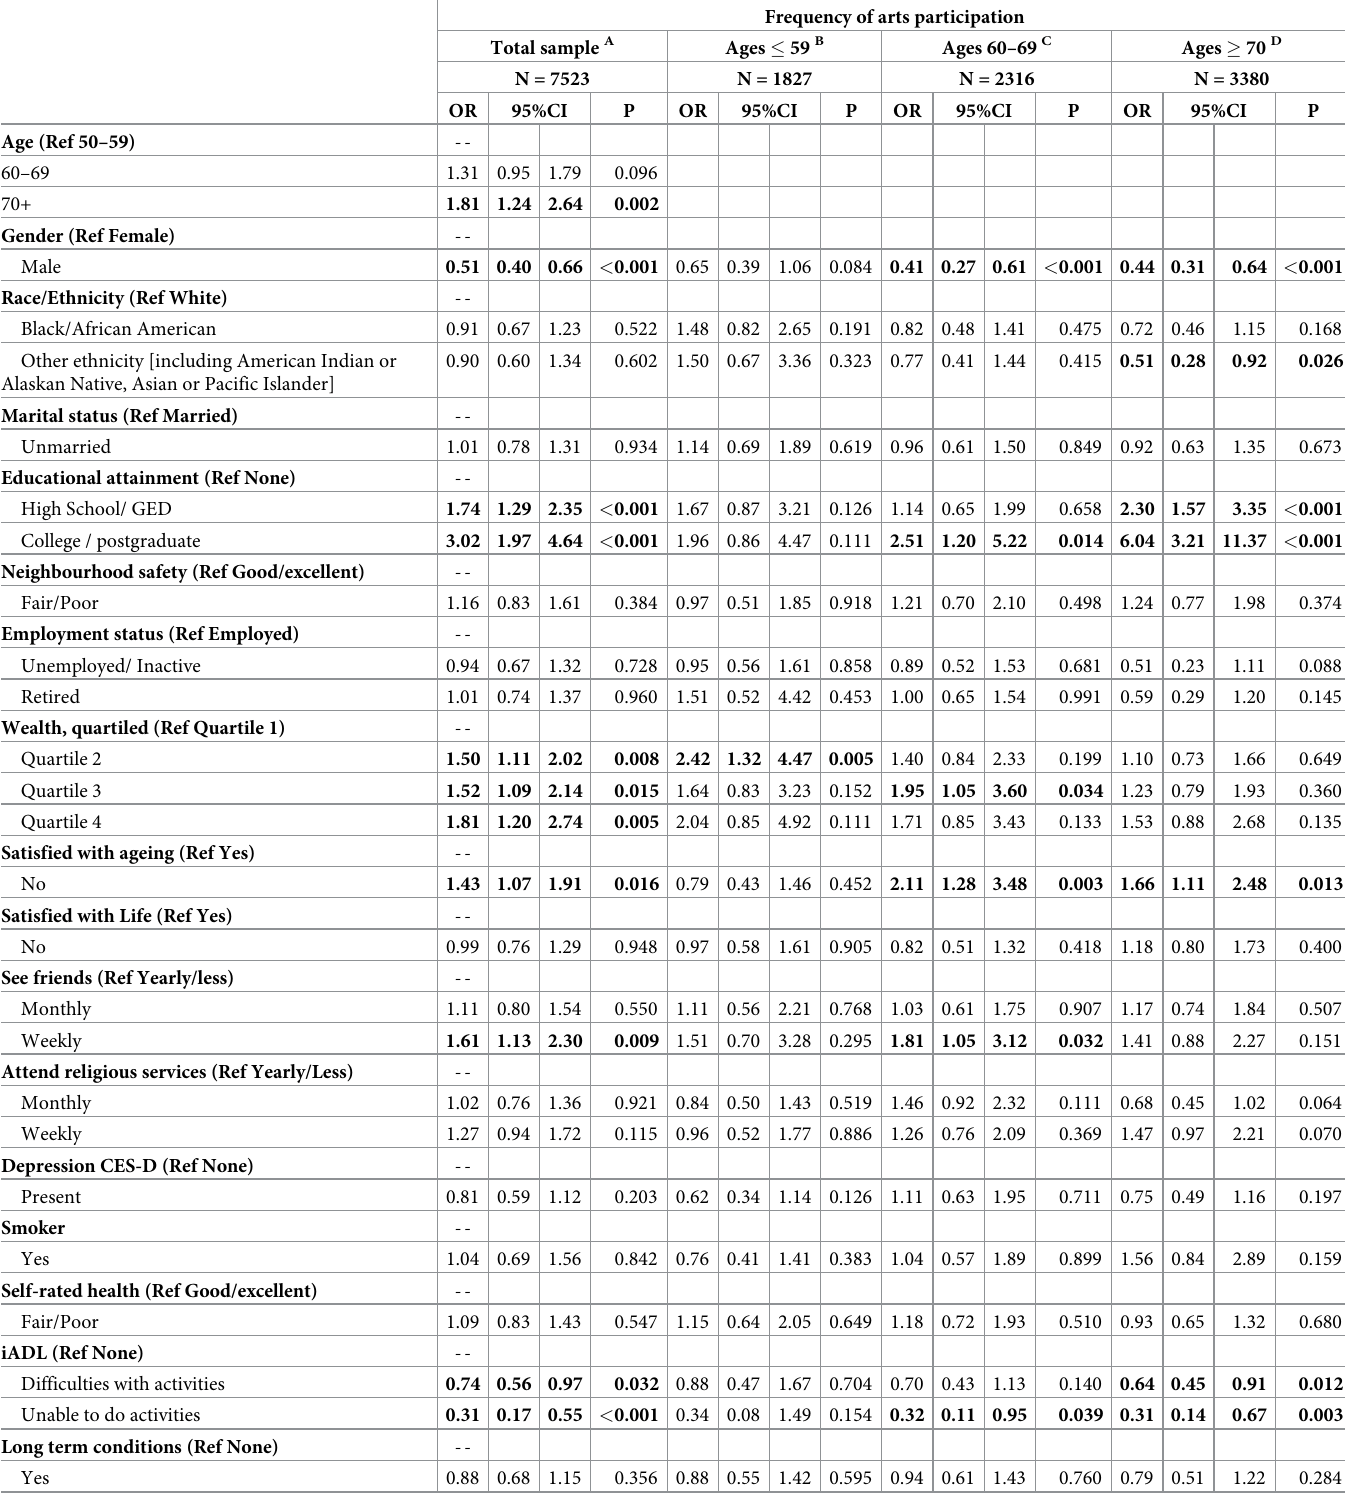
Table 1. Age related differences in predictors of frequency of arts participation in the past 12 months from logistic regression